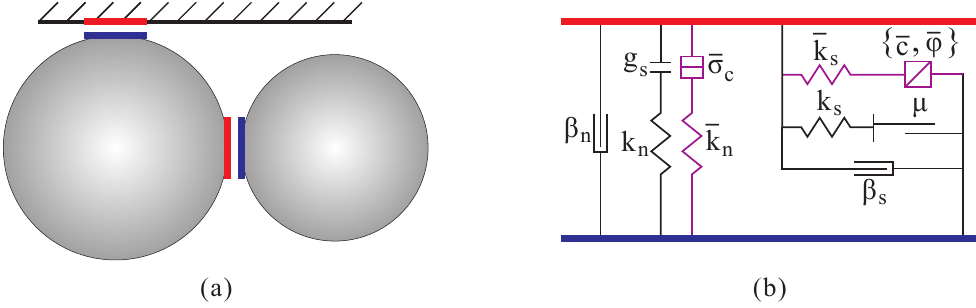
Figure 3. ( a ) Illustration of the contact between particles or between particle and wall; and ( b ) the contact model (the purple colored parallel bond components correspond to the mortar